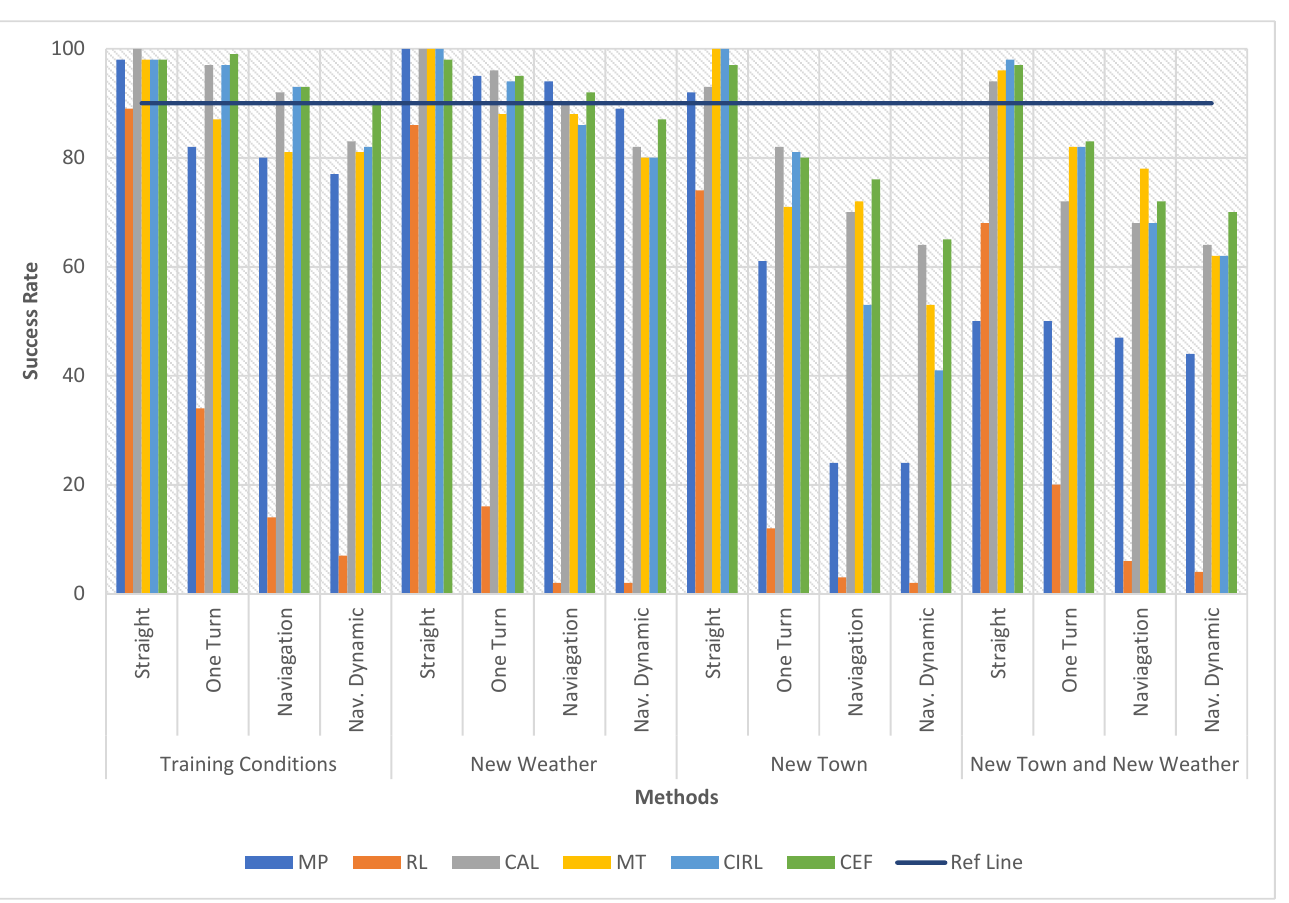
Figure 6. Success Rate Comparison with Previous Methods.